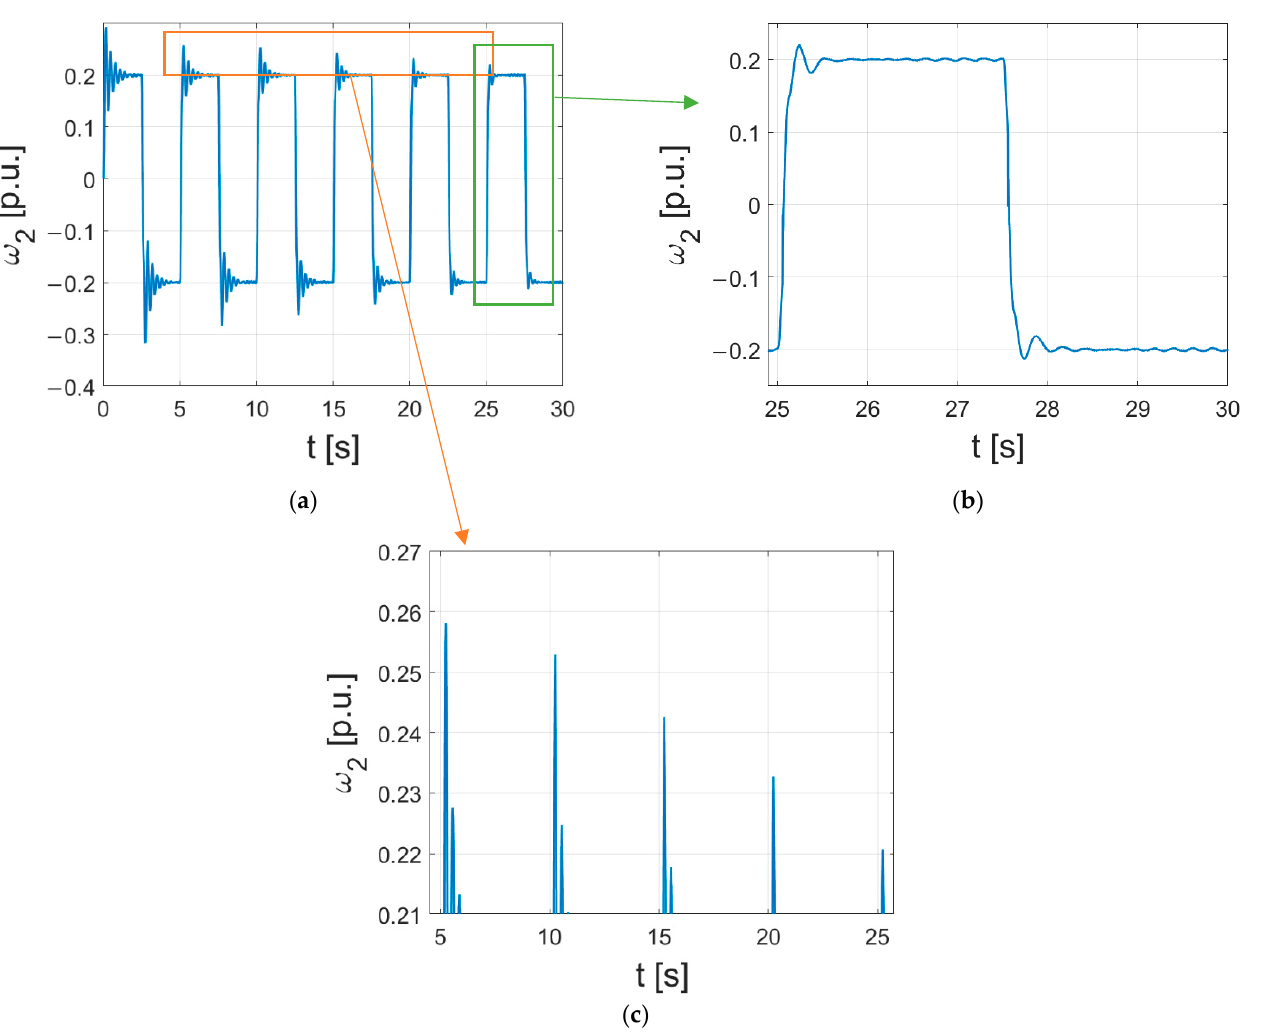
Figure 14. The work of the controller under the altered conditions—an additional plate mounted on the side of the load machine: ( a ) the general overview of the experimental run; ( b ) a zoom-in presenting the final reversions of the experimental run; ( c ) a zoom-in presenting the highest value of the load angular speed after every reversion.